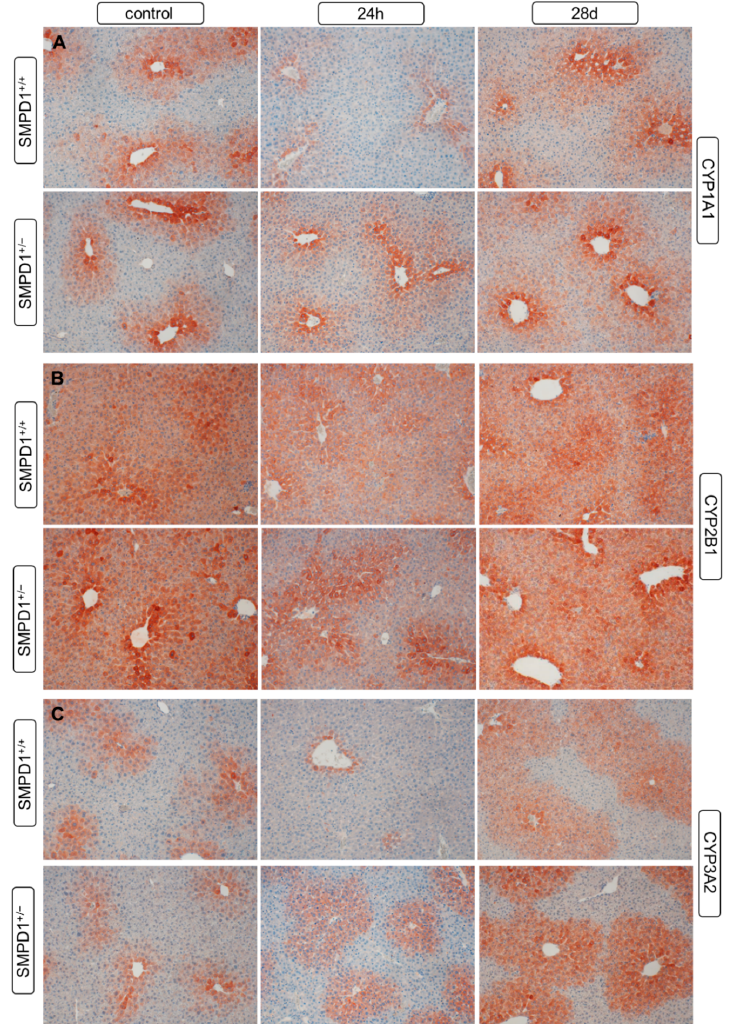
Figure 5. Hepatic cytochrome P450 isoforms expression following polymicrobial sepsis induction. Expression of hepatic monooxygenases (( A ) CYP1A1, ( B ) CYP2B1, ( C ) CYP3A2) was determined using immunohistochemistry (red-brown color, counterstaining with hematoxylin) in SMPD1 +/+ as well as